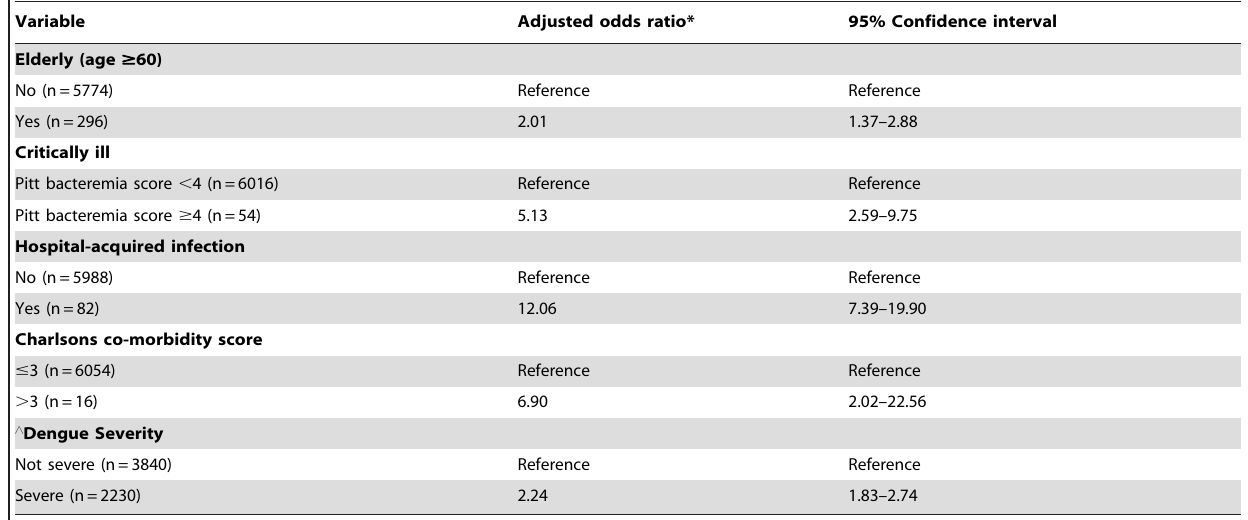
Table 3. Excess length of hospital